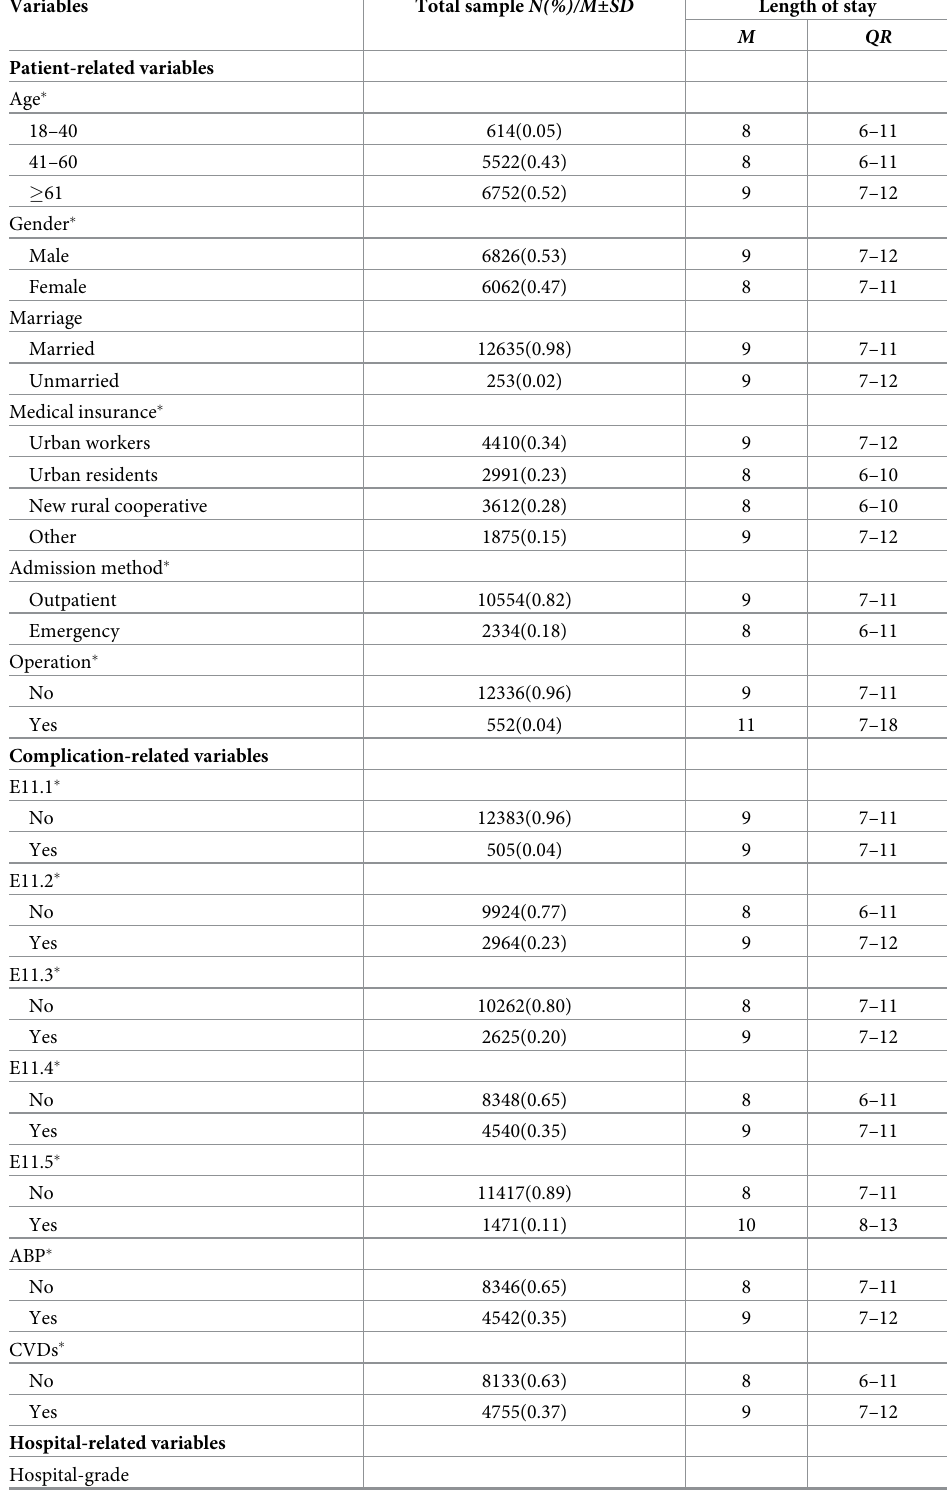
Table 3. General description and univariate analyses of LOS variations for